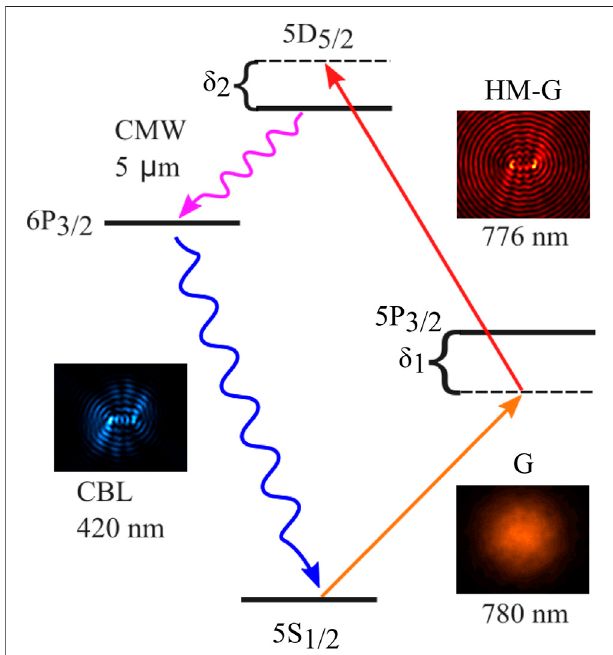
FIGURE 1 | Set of Rb 87 transitions yielding collimated blue light through its second decay during four-wave mixing. Here, the 5S 1/2 → 5P 3/2 was excited by a helical Mathieu – Gauss beam, whilst the 5P 3/2 → 5D 5/2 was induced with light carrying a Gaussian pro fi le.